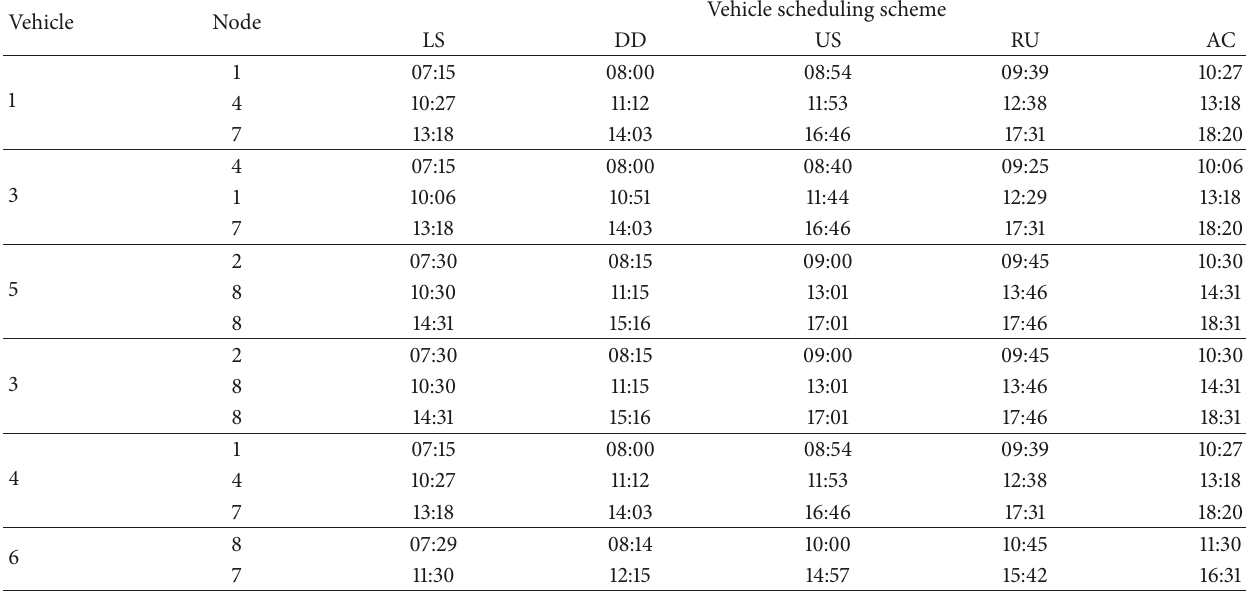
Table 6: Vehicle scheduling plan (for solution